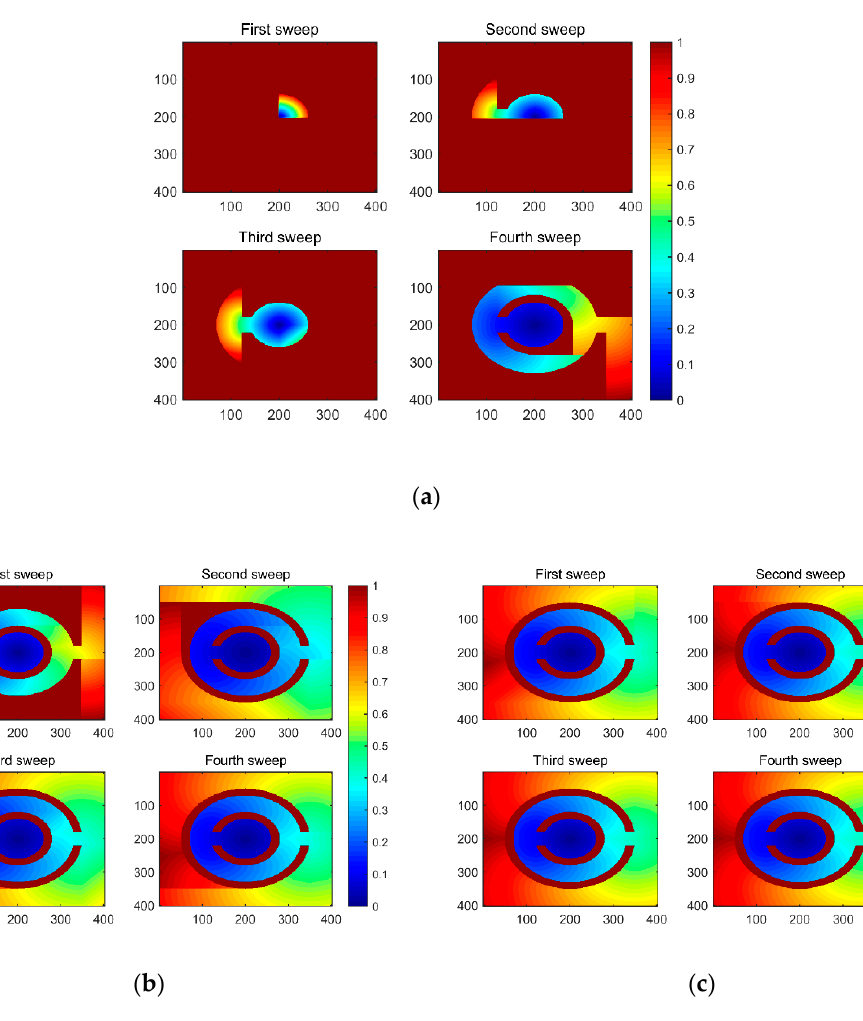
Figure 4. The potential field constructed by the FSM in a space with obstacles: ( a ) first iteration; ( b ) second iteration; ( c ) third iteration.